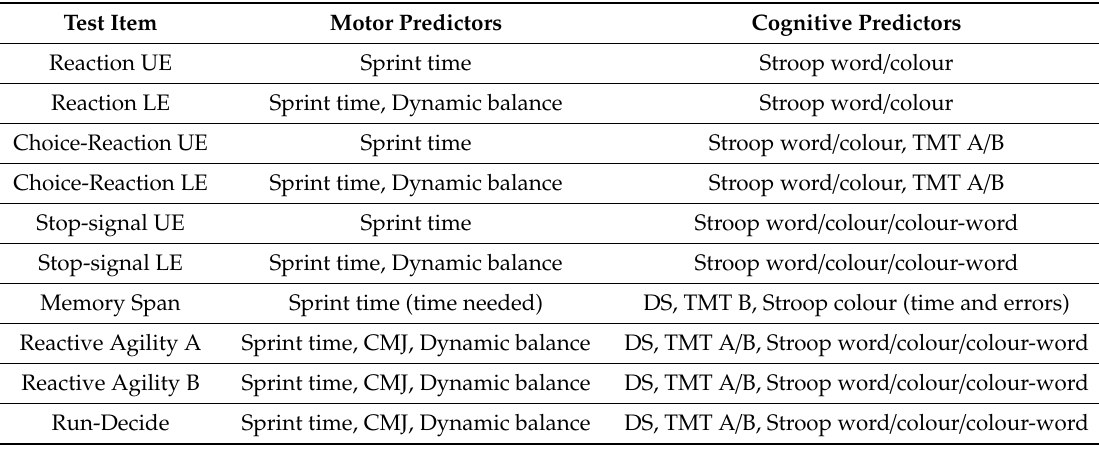
Motor-cognitive testing items and assumed correlations with general cognitive and motor